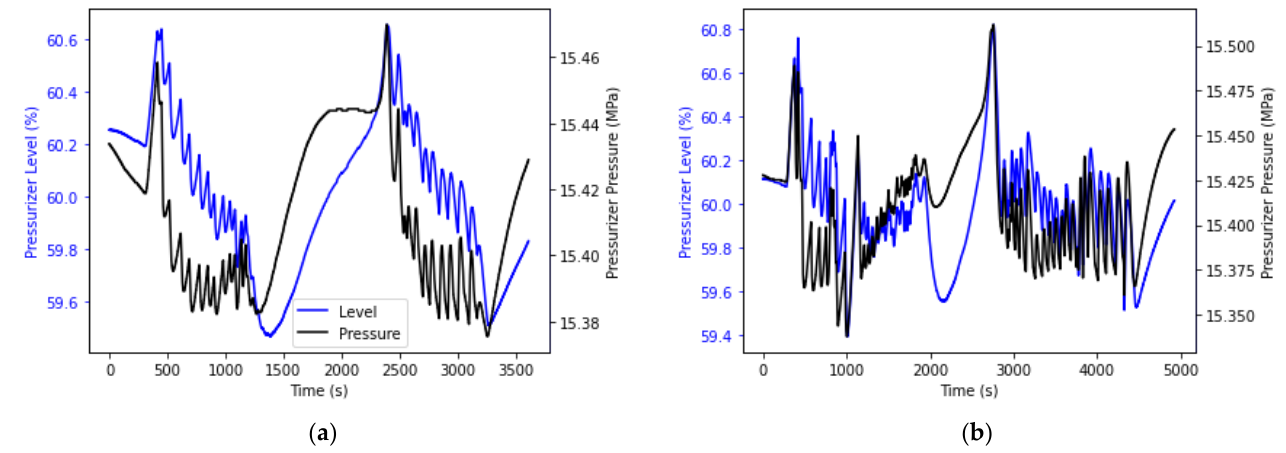
Figure 8. Pressurizer pressure and level during the transitions between pure electric power generation and mixed-mode power generation. Results are shown for 15% TPE ( a ) and 50% TPE ( b ).